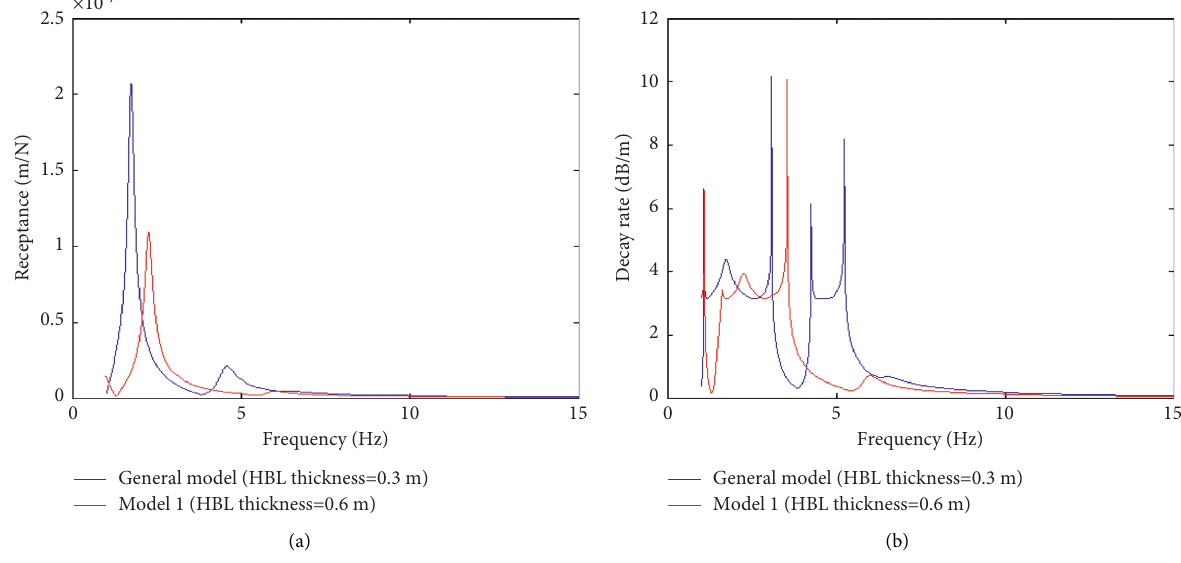
Figure 8: Effect of thickness changes on receptance and the decay rate of HBL: (a) effect of modulus on receptance and (b) effect of modulus on the decay